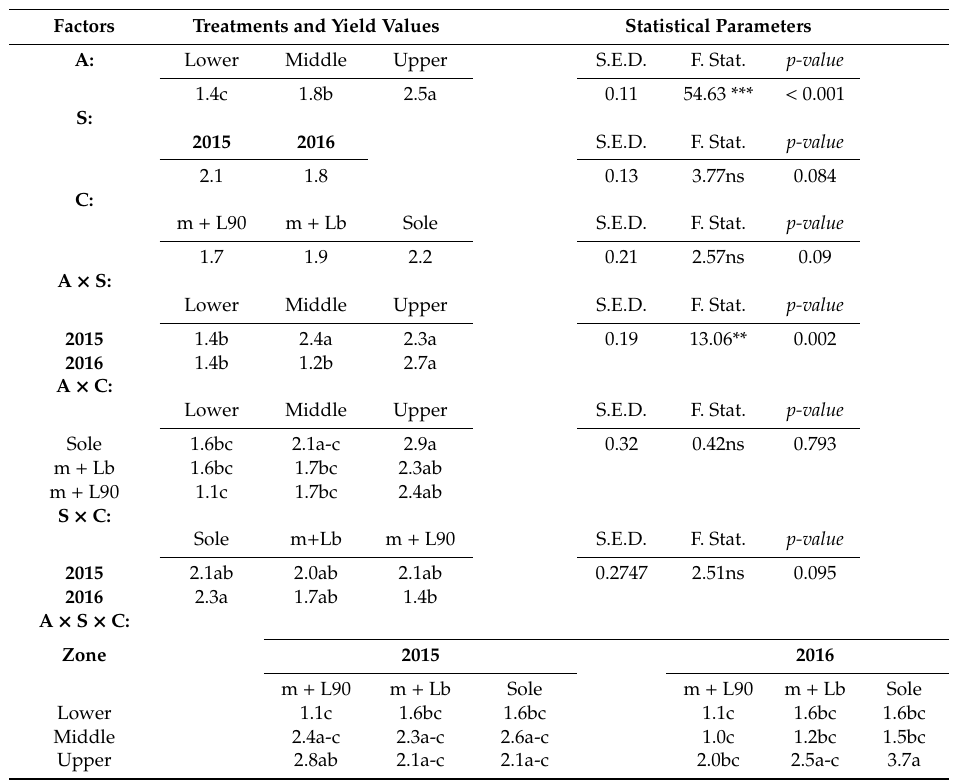
Table 4. Maize grain yields (in t ha − 1 ) recorded over two cropping seasons (2015 and 2016) as a ff ected by the agro-ecological zones, cropping seasons (in years), cropping systems with beans, and the interactions of these